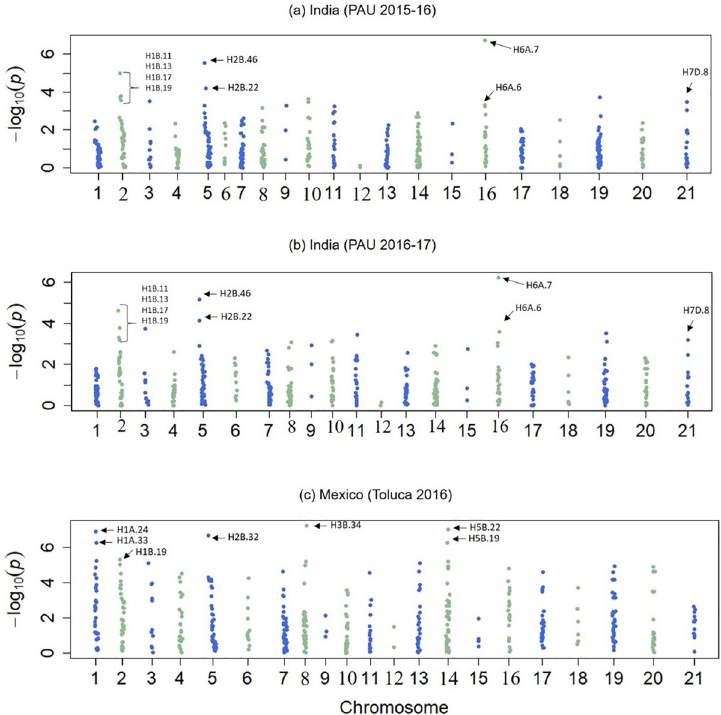
Fig 7. Manhattan plots presenting significance of haplotype blocks with YR resistance in the Mexican wheat landrace core set population in India (two seasons in Punjab Agriculture University, Ludhiana) and one season in Toluca, Mexico. Significance (-Log 10 P) is presented on Y-axis and chromosomes on X-axis. Chromosome numbers 1 to 21 correspond 1A to 7D respectively.